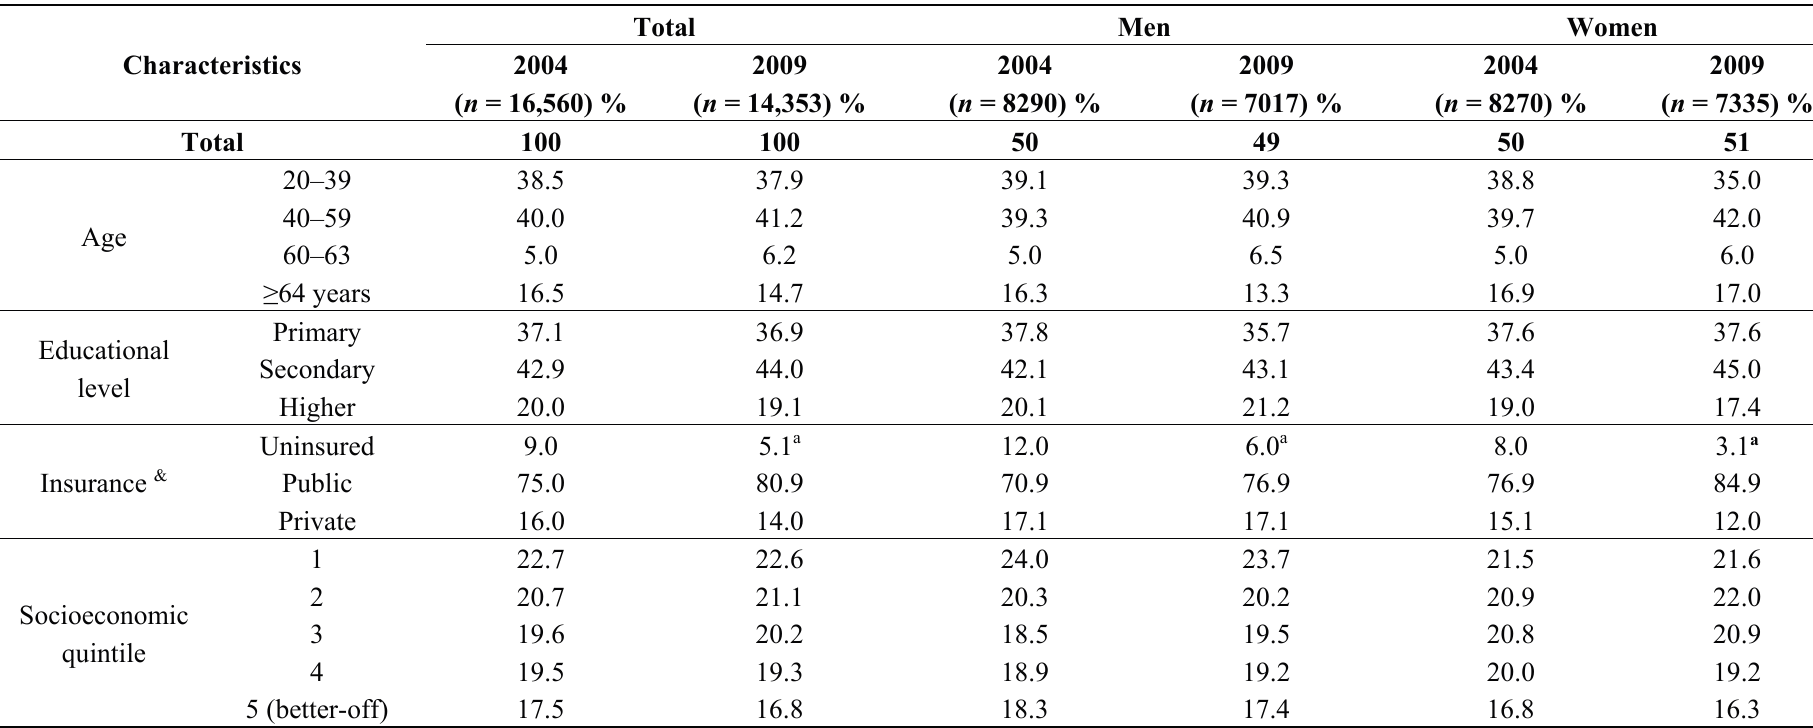
Table 1. Distribution of the study samples in relation to the variables under study. “Social Protection Survey”, Chile 2004 and 2009.